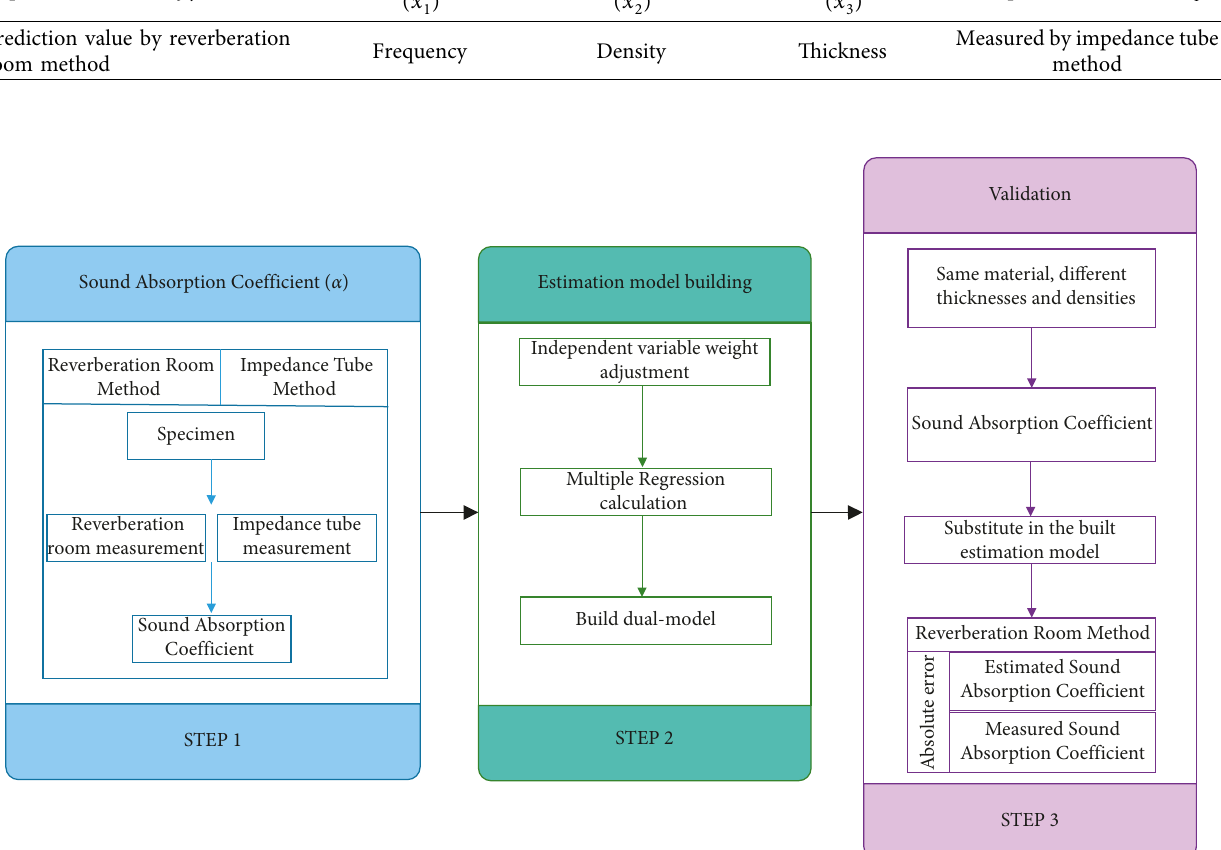
Figure 3: Analysis process chart of bearing failure